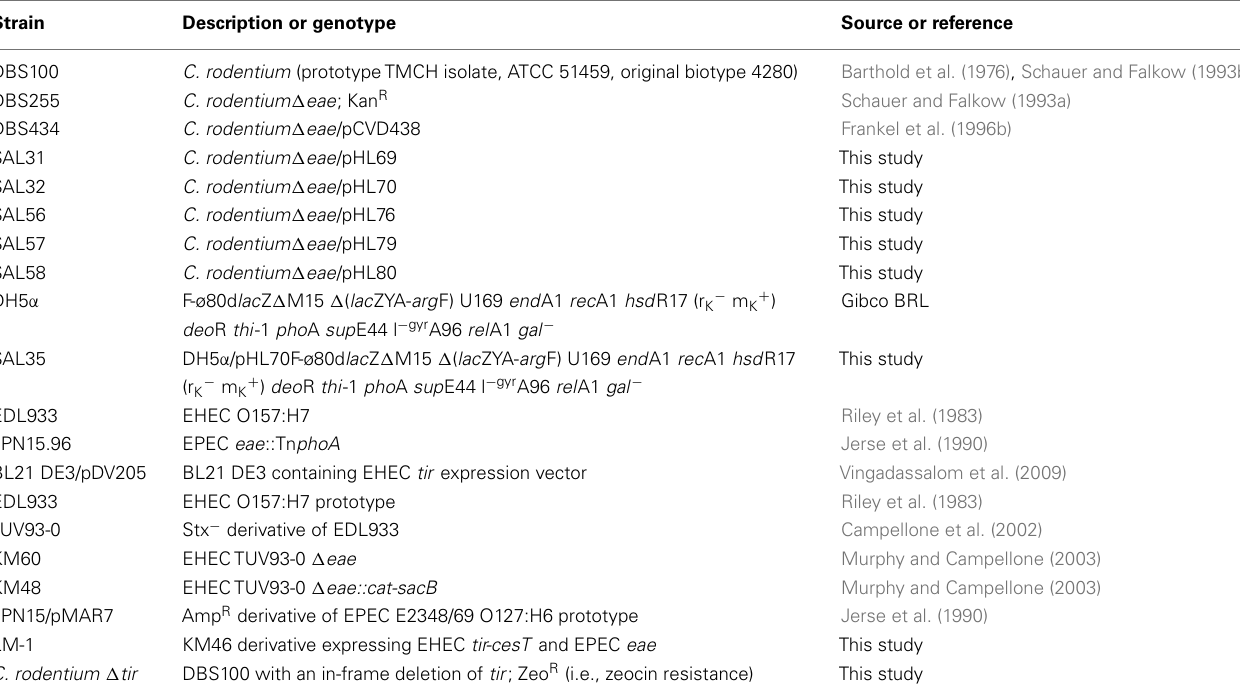
Table 1 | Bacterial strains used in this study.